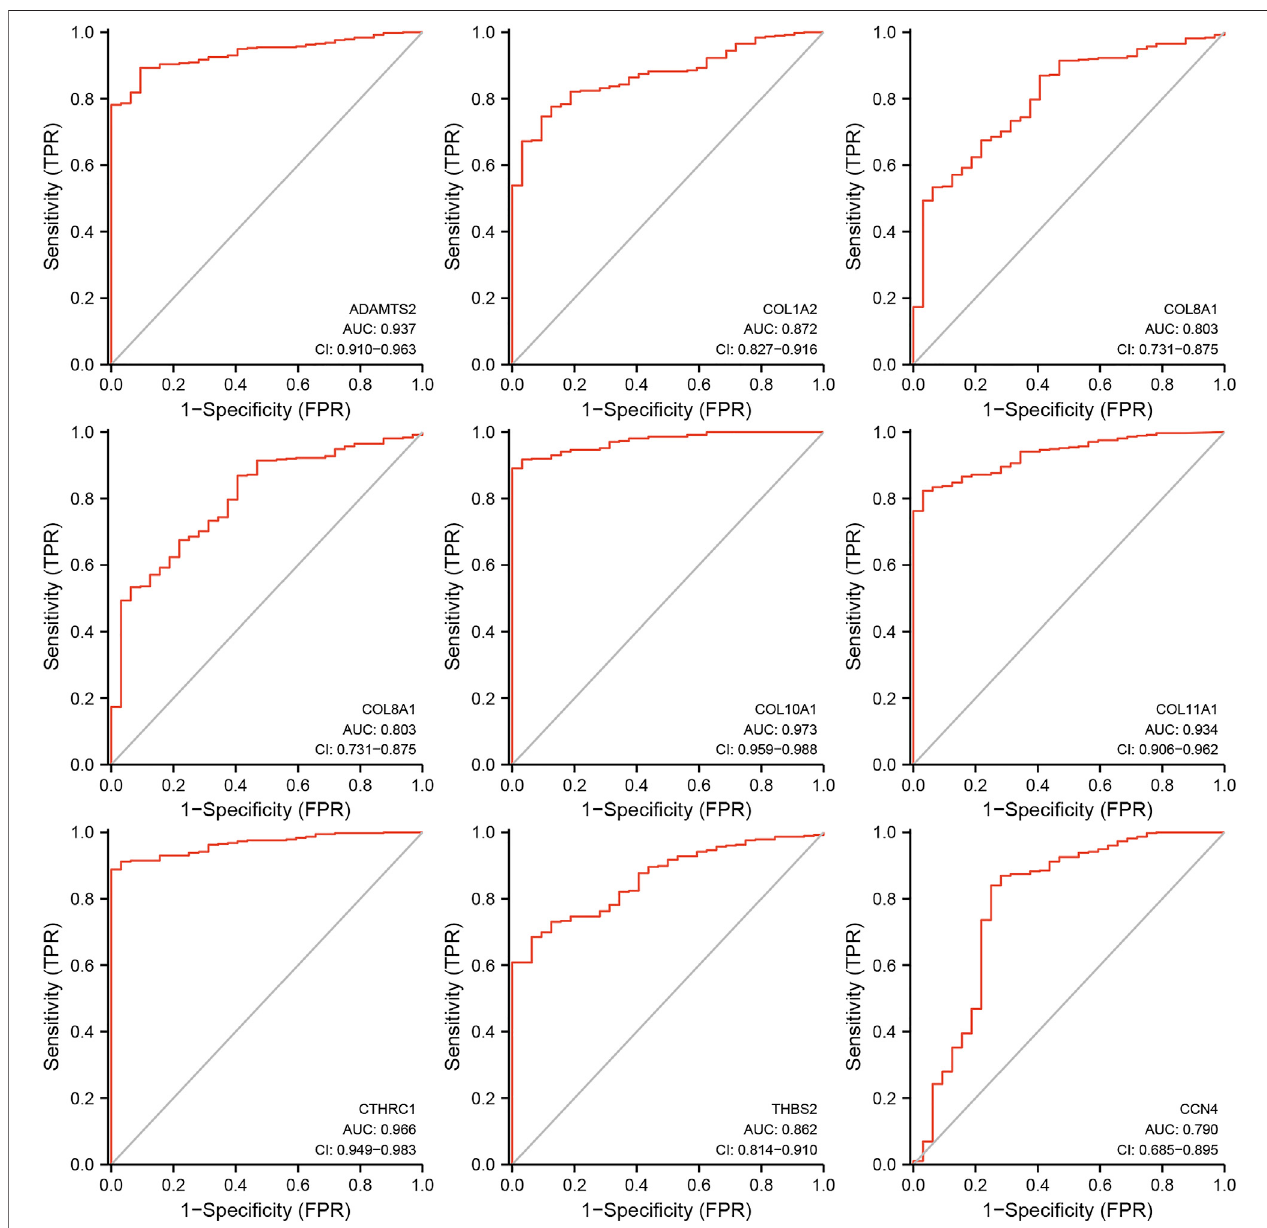
FIGURE 6 | Receiver operating characteristics curve (ROC) curve analysis for the hub genes in gastric cancer.